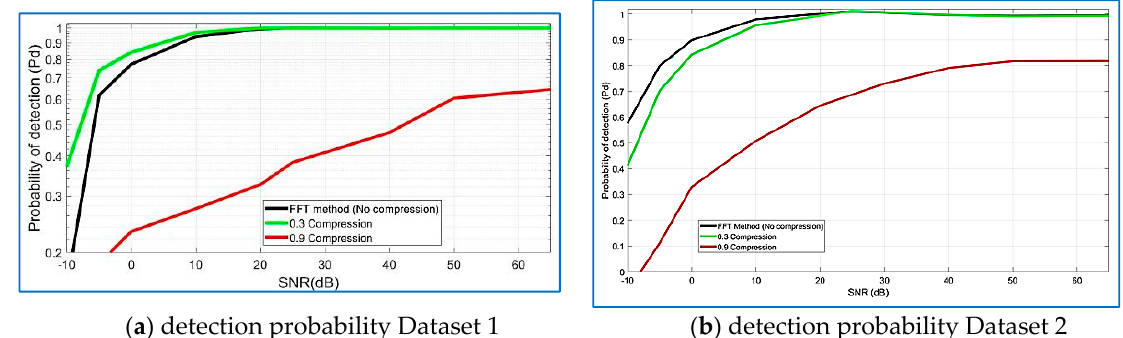
Figure 25. Distribution of the detection probability for several SNRs, Dataset 1 and Dataset 2.